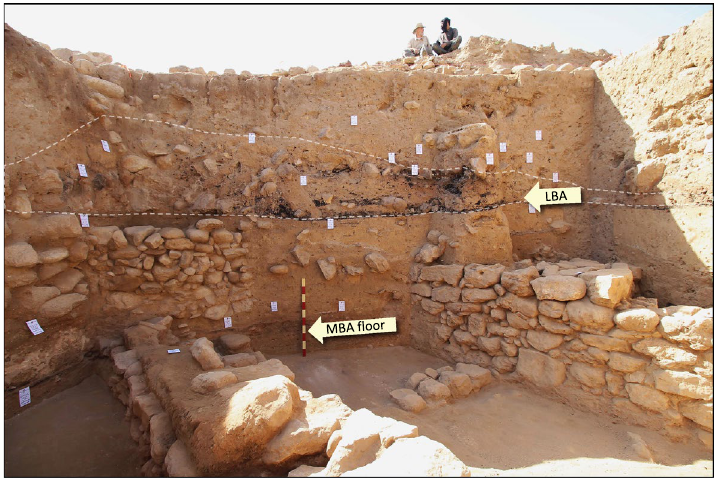
Figure 6. Multiple burned layers at Tall el-Hammam. On the upper tall, there are three terminal burn layers: one during the Middle Bronze Age (MB II), another during Late Bronze Age II (LBA), and one higher during the Iron Age (not visible here). Each burn layer represents the end of an archaeological period at the site. Dashed white line encloses LBA burn layer at arrow, representing the burning of a single building at ~ 1400 BCE stacked atop the sheared MB-II walls. “MBA floor” marks the top of the MB II floor beneath the 1.5-m-thick destruction layer dating to 1650 BCE. Two earthquake-related destruction layers (not shown) are buried deeper than the contains high-temperature melted